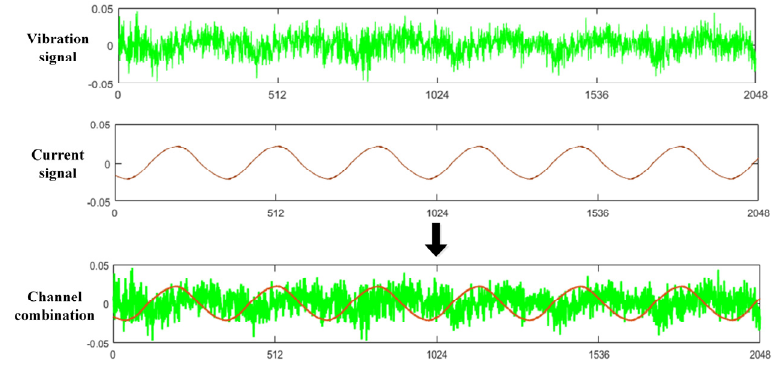
Figure 2. Multi–source signal.